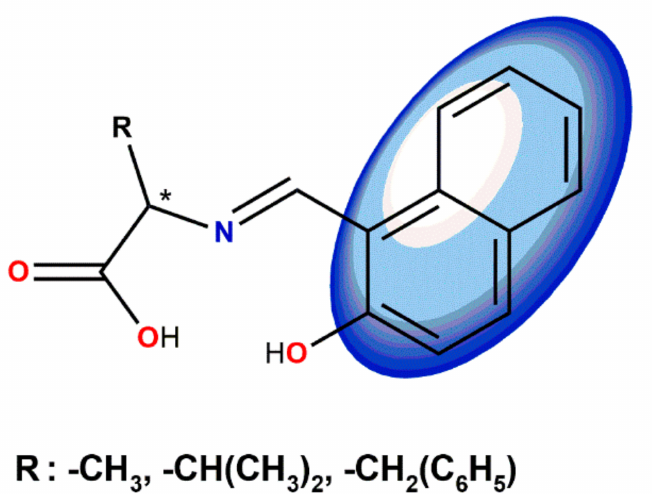
Figure 12. Hydroxy substituted photocatalytic Cu(II) Schiff base complexes studied by Miyagawa et al. (R = -CH 3 (CuADB), i -propyl (CuVDB); L = methanol) and the reduction rate of Cu(II) complexes and TiO 2 in aqueous solutions after UV light irradiation [73].